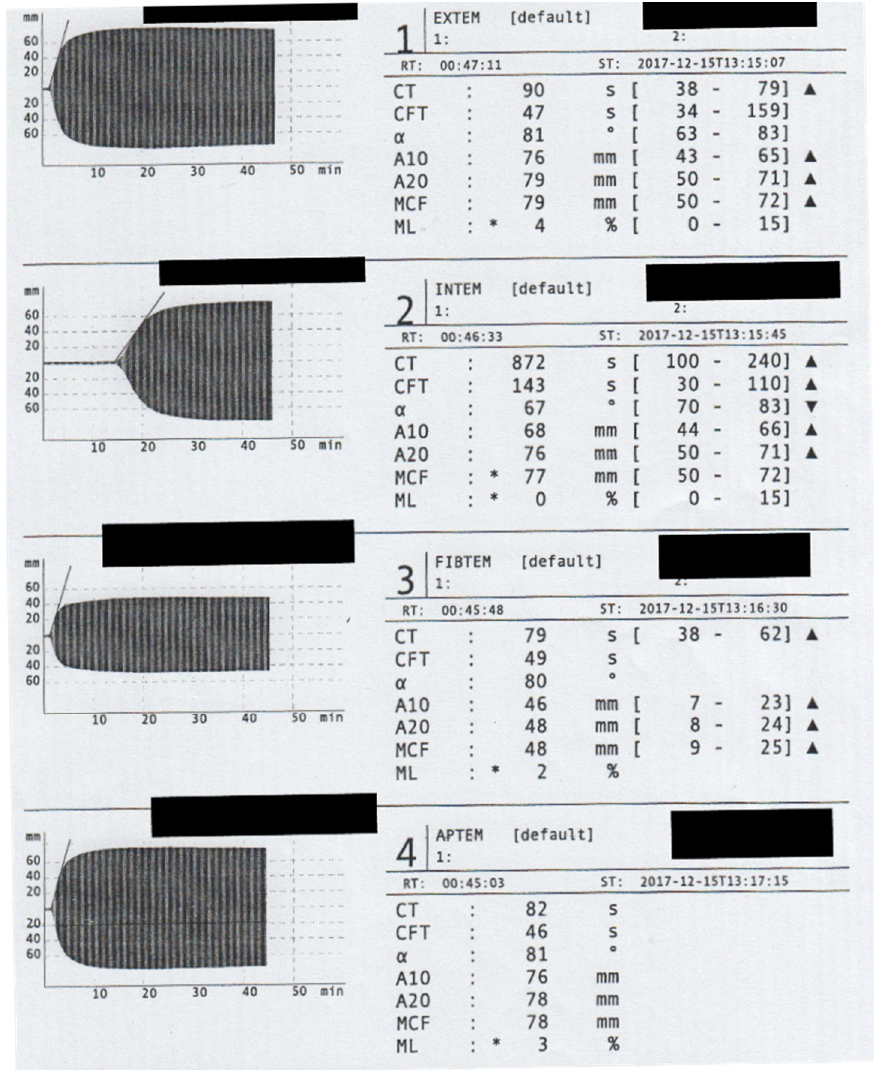
Figure 1. Rotem assessment on Admission. The Rotem analyses showed a significant prolongation of the clotting time (CT) in the INTEM channel. To prevent Heparin administration, we did not conduct a HEPTEM assay. The maximum clot firmness (MCF) in the EXTEM assay (79 mm) is mainly caused by the extremely high fibrin polymerization recorded in FIBTEM channel (MCF = 48 mm). Emergency relaparotomy was indicated as the patient’s abdomen was still packed even after bleeding was controlled. Recombinant activated FVII (rFVIIa; NovoSeven ® ) was administered in a dose of 90 µ g/kg body weight. Due to the half-life of rFVIIa of 1.5 h, the same dose was readministered every 3 h perioperatively for the next 72 h (cumulative 48 mg per